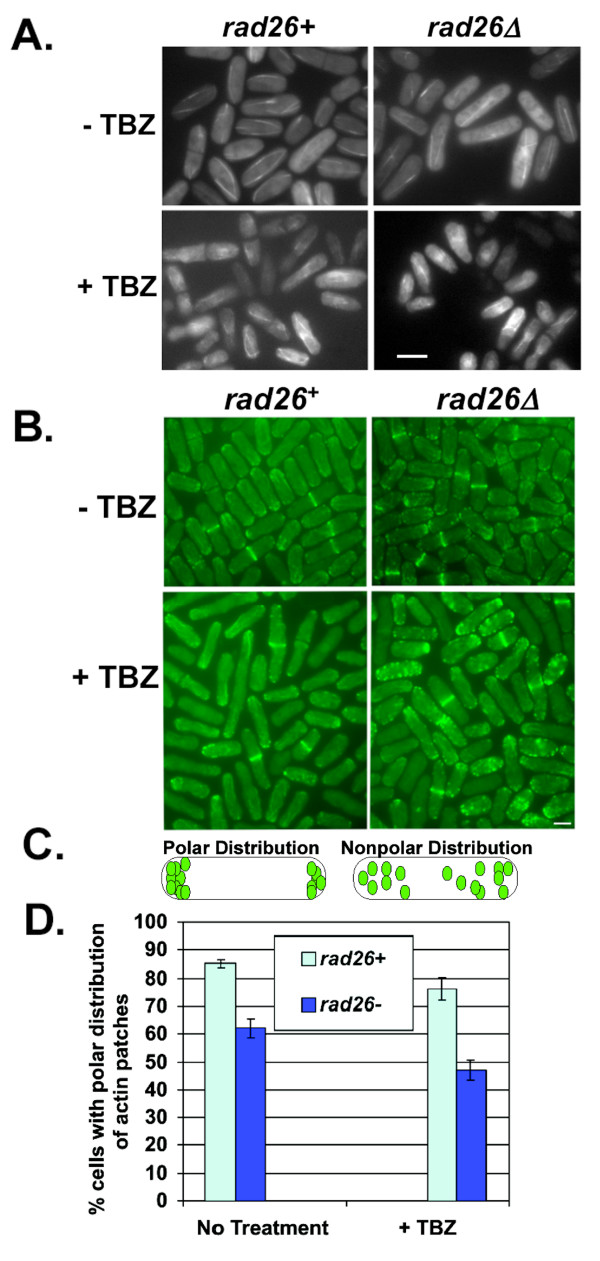
Loss of rad26+ affected the polar distribution of actin patches but not gross microtubule architecture. A. Gross microtubule architecture was not affected by loss of rad26+. rad26+ (1226) and rad26Δ (1248) cells expressing ectopic atb2-gfp were grown in EMM + 0.2 μM thiamine. TBZ (20 μg/ml) was added to half of each culture for 5 hours, after which cells were fixed with methanol and processed for microscopy. Bar = 4 μm B. rad26+ is required for the polar distribution of actin patches. rad26+ (TE236) and rad26Δ (TE257) cells were grown in YE5S liquid. Half of each culture was treated with 20 μg/ml TBZ for 5 hours before fixing and staining with FITC-Phalloidin (see Methods). Bar = 5 μm C. A diagrammatic representation of polar and non-polar actin patch distributions. D. Graphical representation of data collected from B.